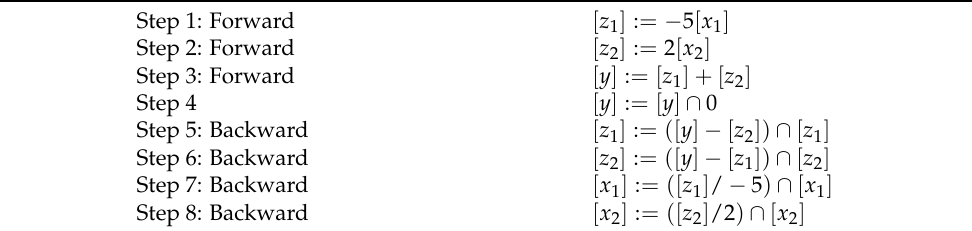
Table 2. Steps of C